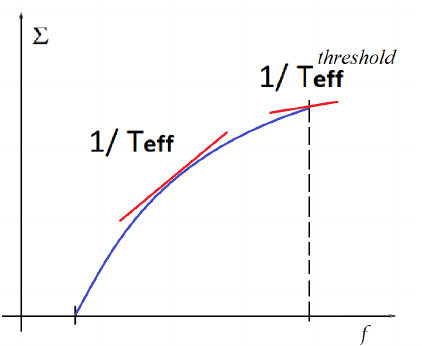
Figure 5: Schematic picture of the complexity Σ as a function of the free energy f for the p -spin glass model. The dotted line represents the threshold free energy. The red line is the slope of the function Σ ( f ) and determines the effective temperature of the